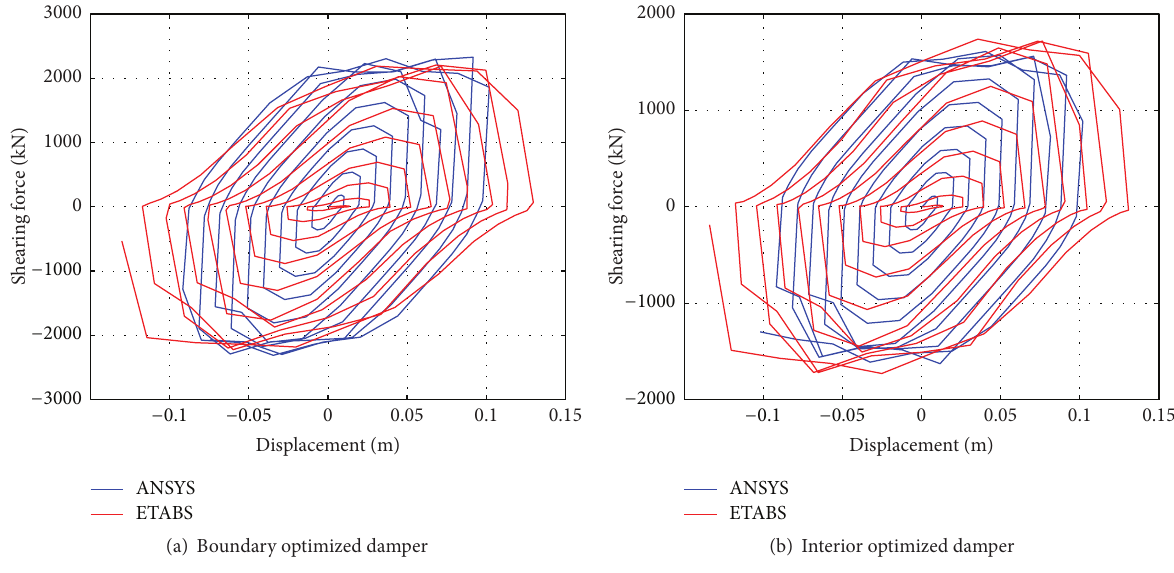
Figure 29: Comparison of hysteresis curves using ANSYS and ETABS.